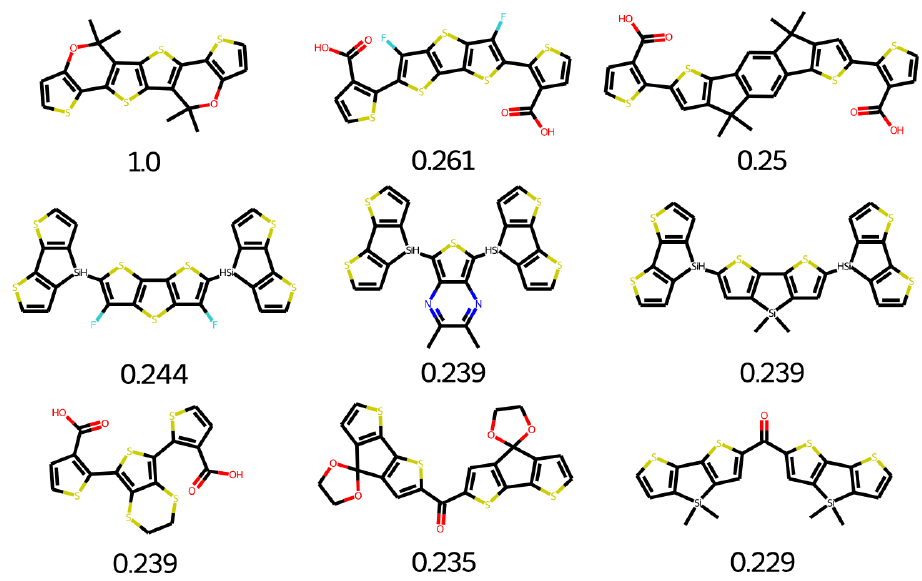
Figure 17. Top search hit for O4TIC.